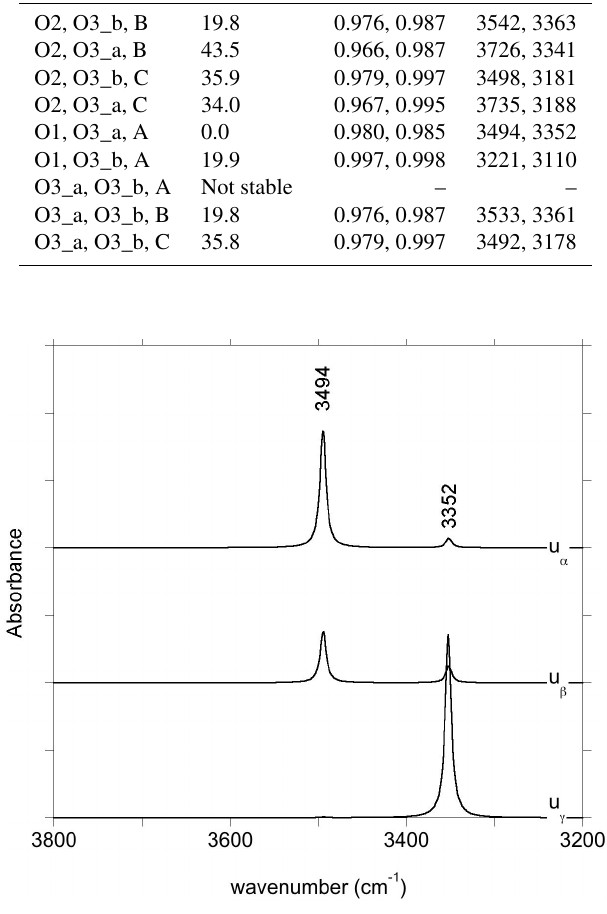
Figure B1. Theoretical infrared spectrum of